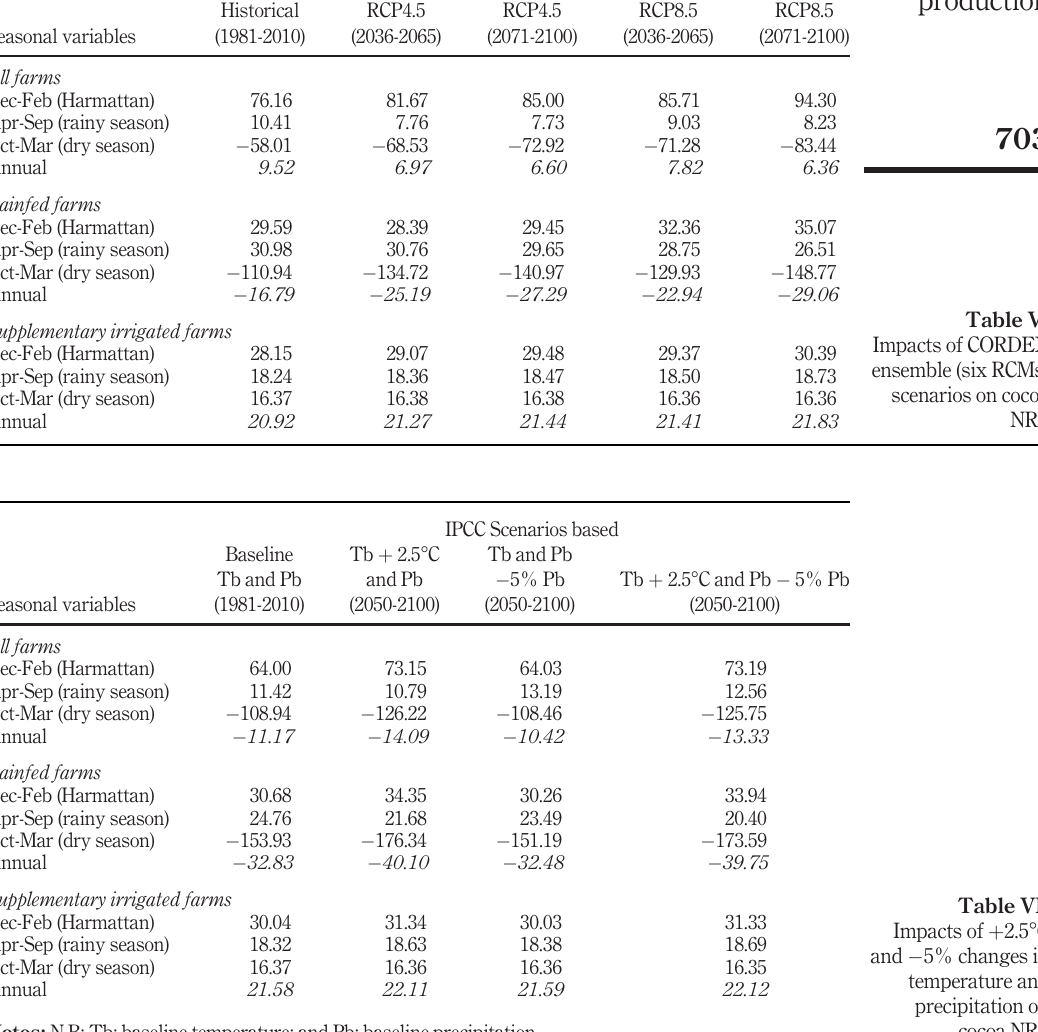
Table VI. Impacts of þ